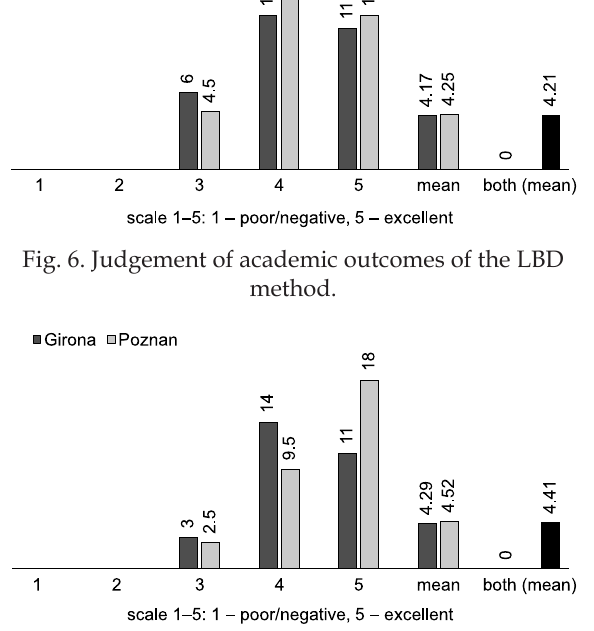
Fig. 7. Judgement of personal outcomes of the LBD